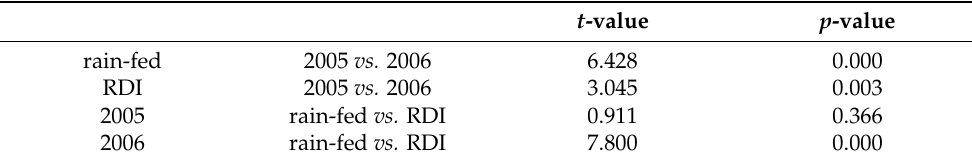
Table 4. Tests (Student’s t) for the difference between linear regression slopes.